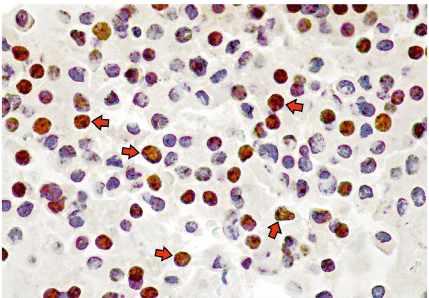
Figure 1: Sparsely granulated somatotroph adenoma with strong and extensive nuclear reactivity for ZAC-1, indicated with illus- trative arrows (Immunohistochemistry, Hematoxyline-DAB,